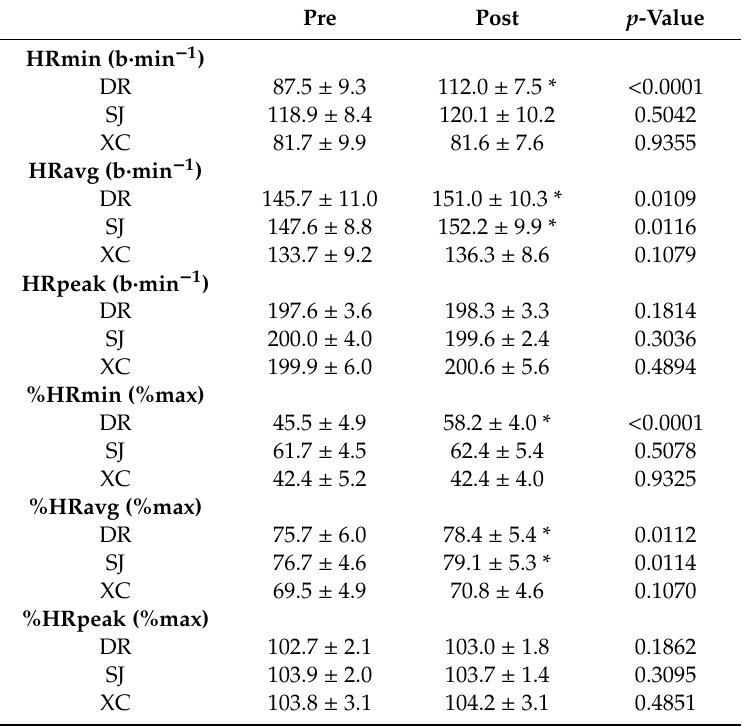
Table 2. For Dressage (DR), Show-jumping (SJ) and Cross-country (XC) competition minimum (HRmin), average (HRavg), peak (HRpeak) heart rate absolute and relative to (%max) values are reported as mean ± standard deviation, p -values are reported for di ff erences between pre and post lockdown